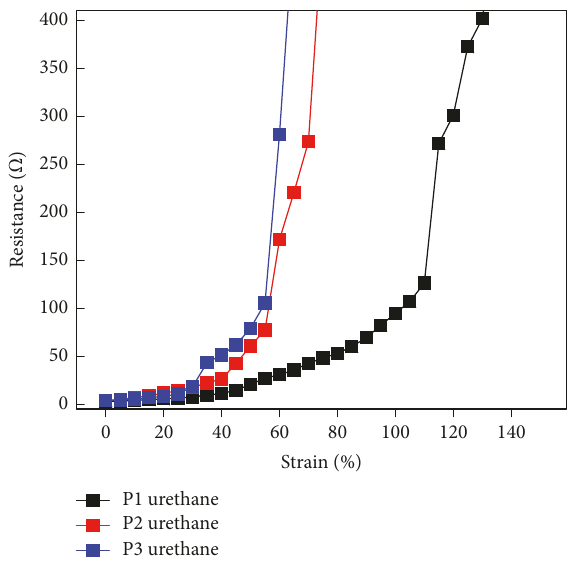
Figure 7: Electrical resistance versus tensile strain plot of patterned Ag electrode films.